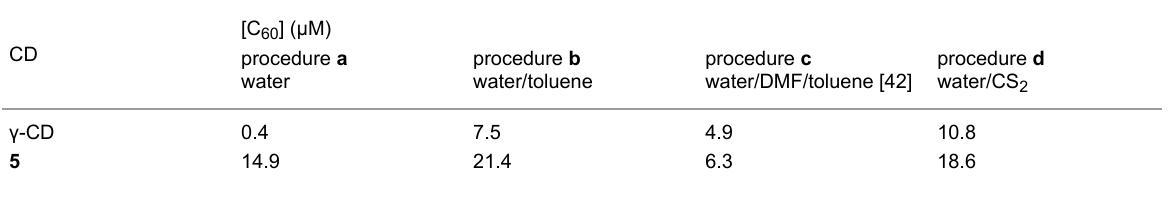
Table 2: C 60 concentration in 6.0 mM aqueous solutions of γ -CD and γ -CD thioether 5 .